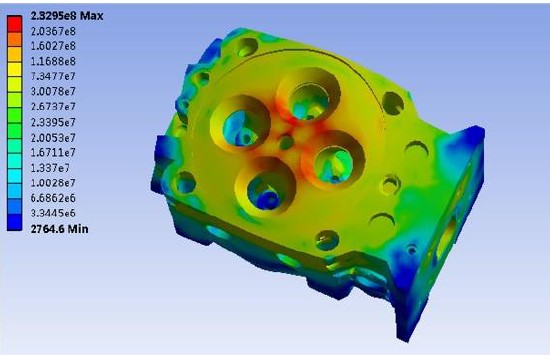
Figure 11. Contour map of the cylindrical head’s thermal stress.